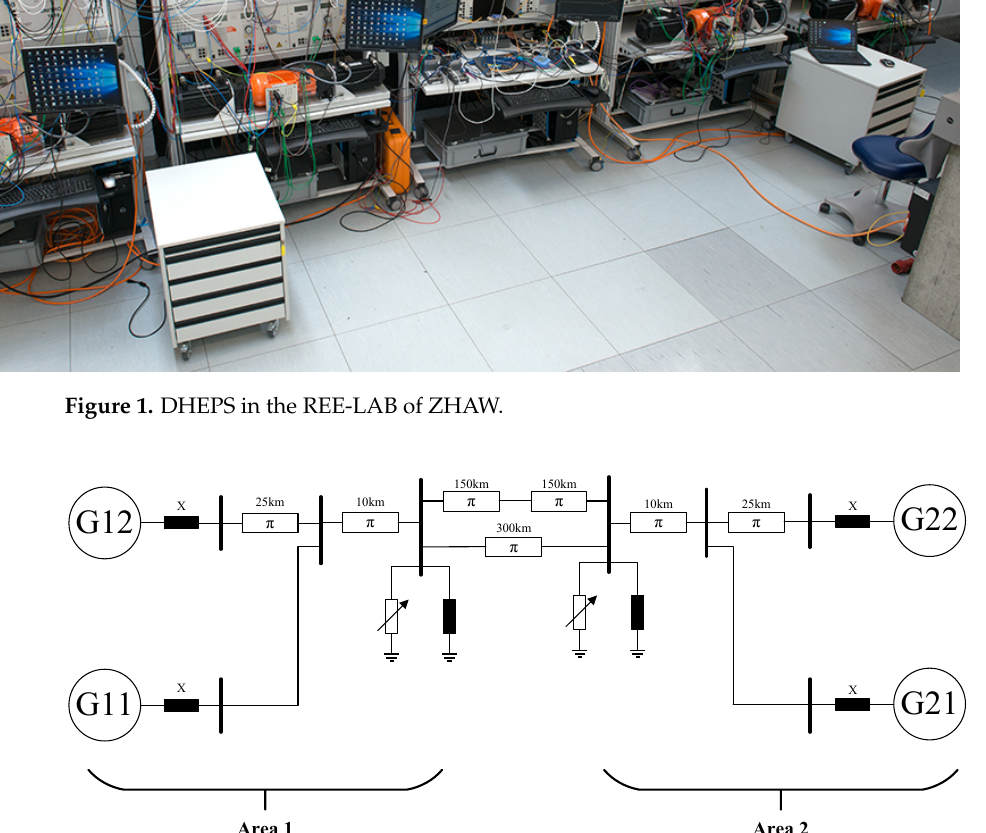
Figure 2. Single line diagram of the dynamic hardware emulator implemented in the lab according to [3] with its main